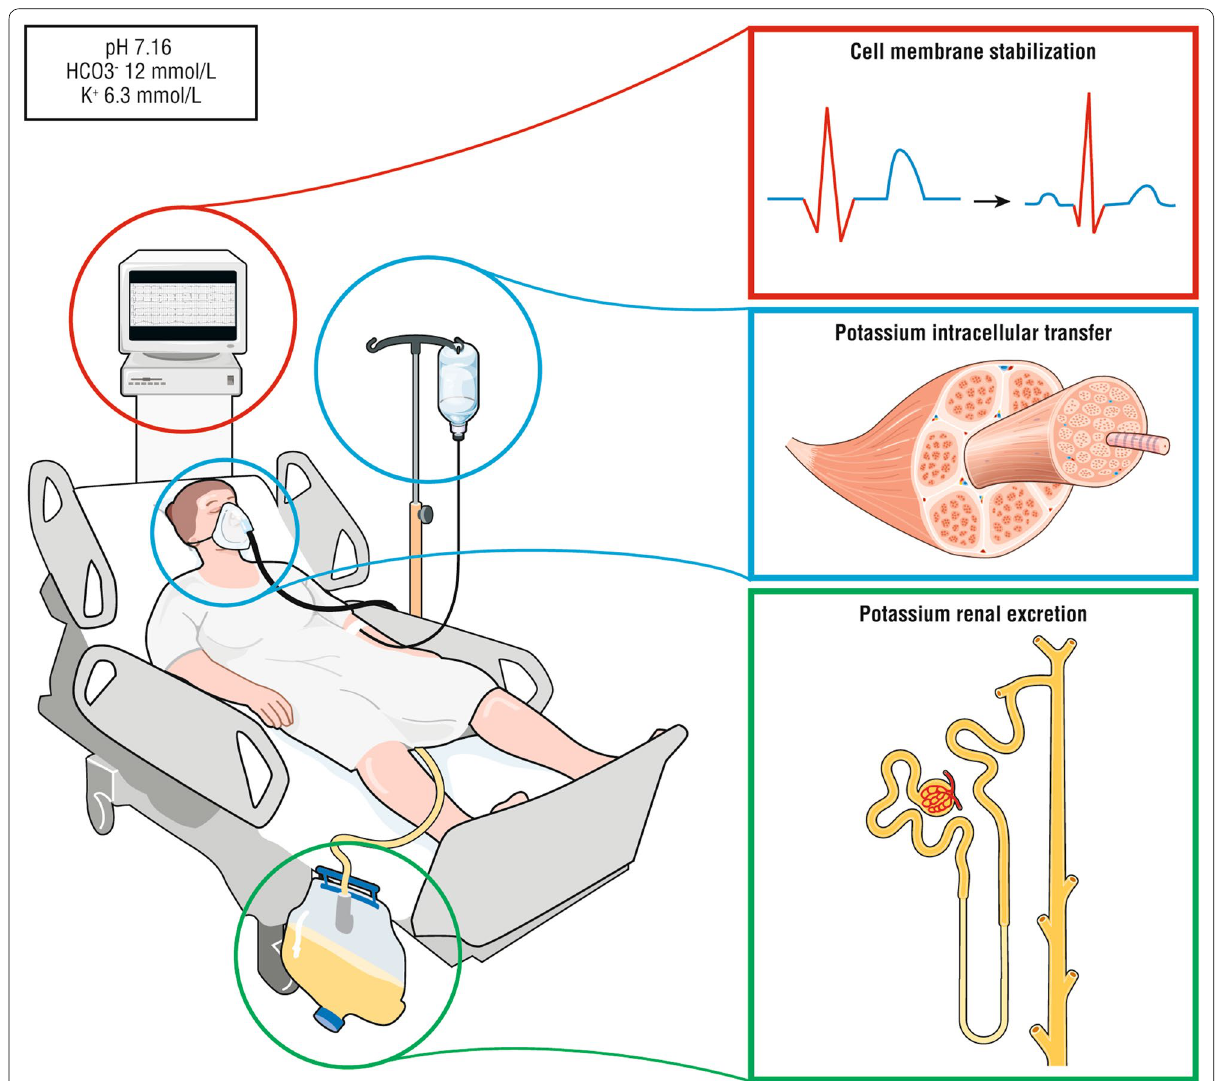
Fig. 5 First-line treatment of hyperkalemia. During hyperkalemia with ECG modifications, first-line therapy should consist on cardiomyocyte stabilization using calcium salt or hypertonic sodium (red panel), second line therapy on treatment leading to a fast transfer of potassium from extracellular to intracellular space using either insulin–glucose i.v, aerosol of β2 agonist and/or sodium bicarbonate (in case of metabolic acidosis and hypovolemic patient) depending of the patient’s comorbidities and clinical status. Insulin–glucose is recommended as the first-line treatment in severe hyperkalemia (i.e., above 6.5 mmol/L) but close glucose monitoring is mandatory. β2 agonists can be used in spontaneously breathing patients but with safety concerns in patients with unstable angina or cardiac failure. Hypertonic sodium bicarbonate should probably be restricted to hypovolemic patients with metabolic acidosis (blue panel). Strategies increasing potassium renal excretion decreases the total potassium pool (i.e., hemodynamic optimization and correction of acute kidney injury or loop Henle diuretics in patients with fluid overload) (green panel). Indications of renal replacement therapy are patients with severe acute kidney injury associated to severe hyperkalemia or persistent